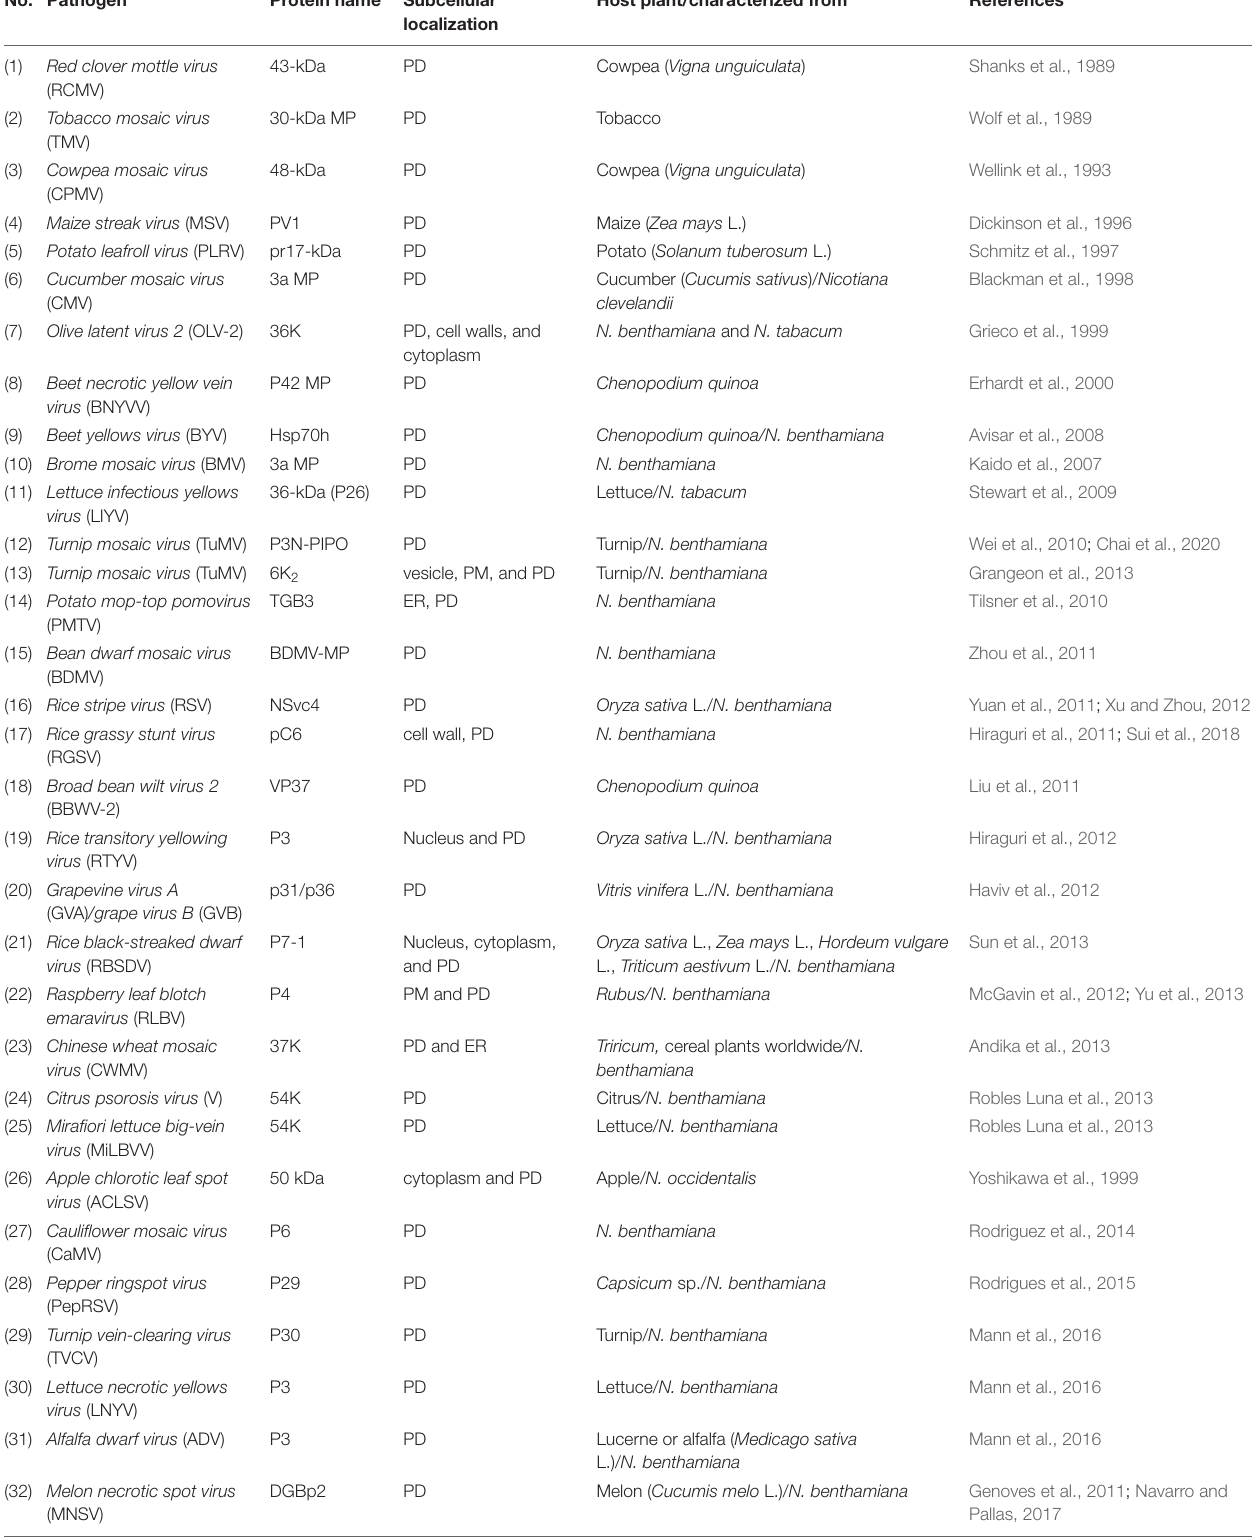
TABLE 2 | List of plants virus/bacterial/fungal-encoded proteins-targeted